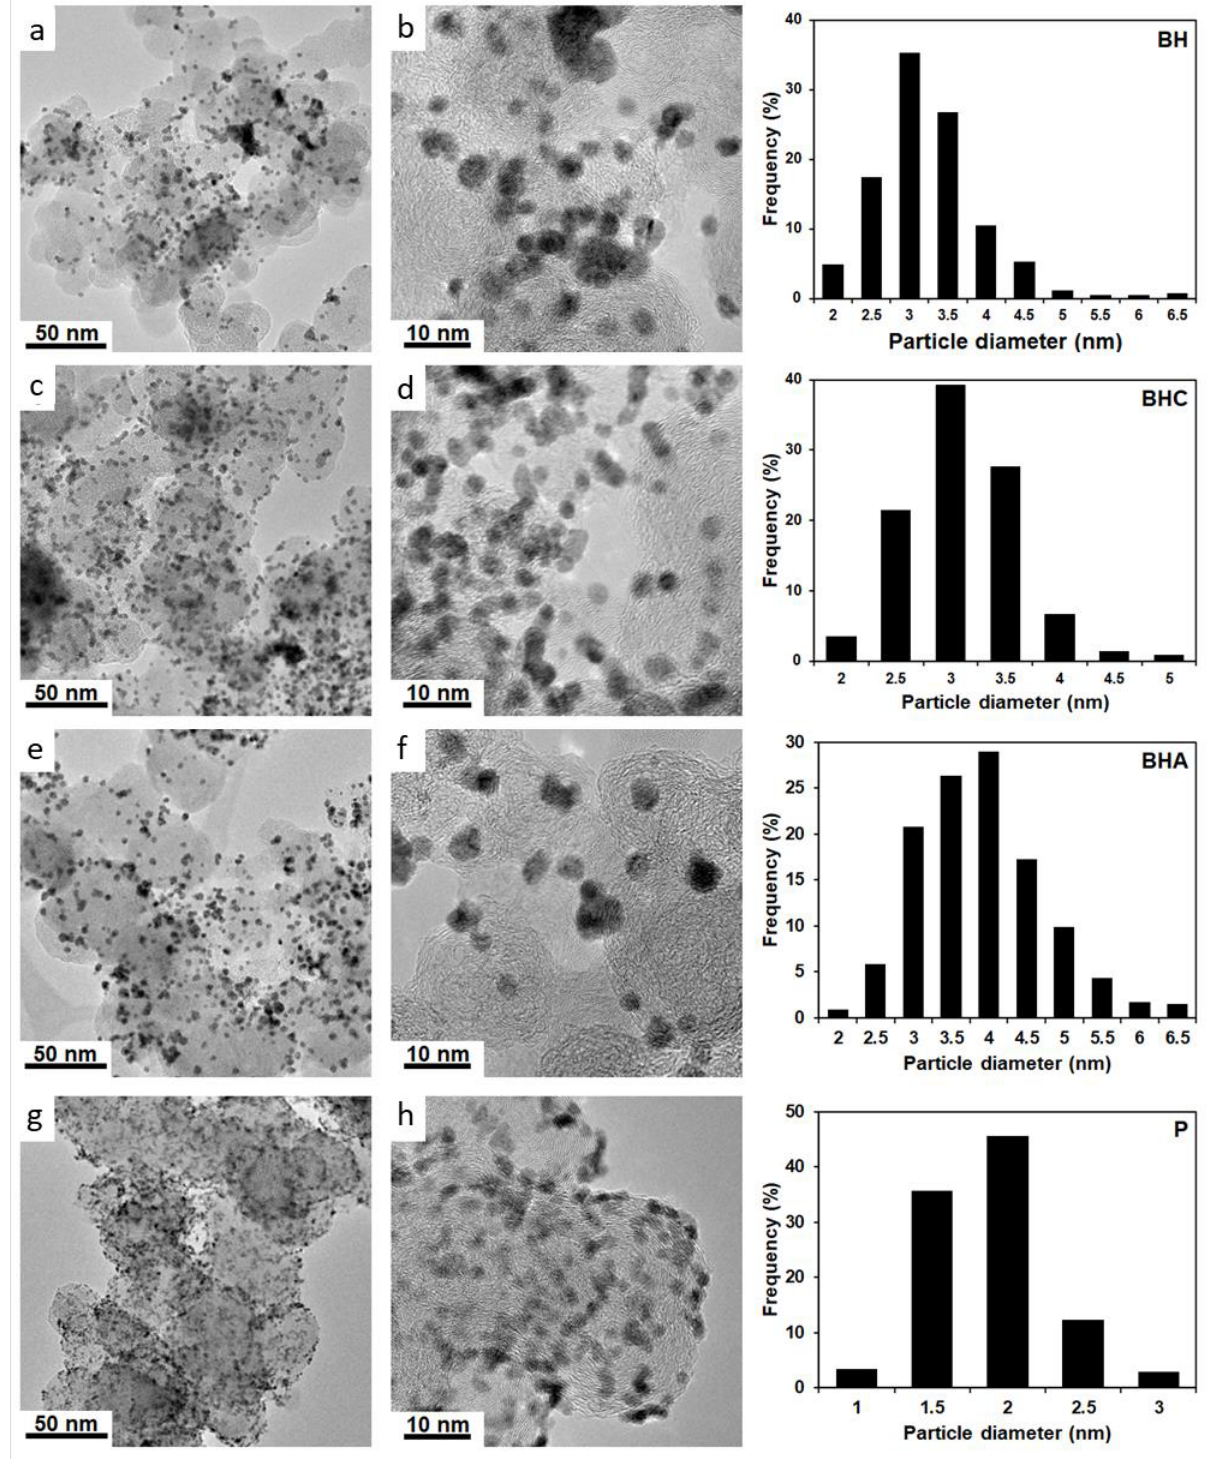
Figure 2. The micrographs of the BH ( a ) and ( b ), BHC ( c ) and ( d ), BHA ( e ) and ( f ), and P ( g ) and ( h ) Pt-based samples and the histograms of the NPs’ size distribution in the corresponding